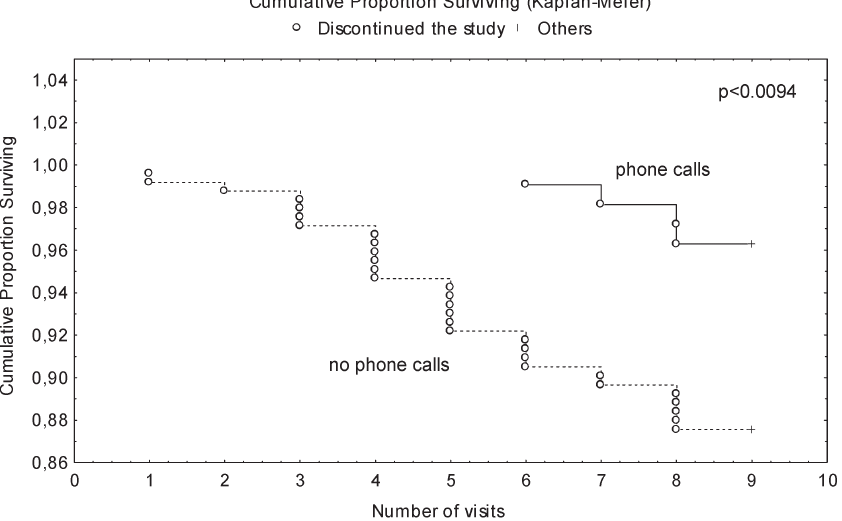
Figure 2 - Discontinuation of antihypertensive treatment.